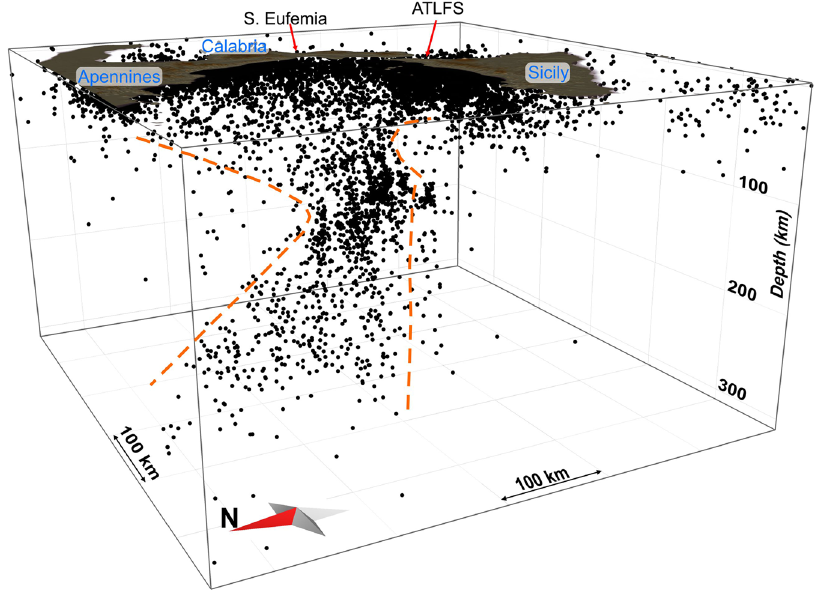
Figure 2. 3D view of the localised earthquakes. The orange dashed lines highlight lateral slab boundaries arising from this study (see Results). The plot was created using Move (version 2017.2; https://www.mve.com) and Corel Draw Graphics Suite (version X5;